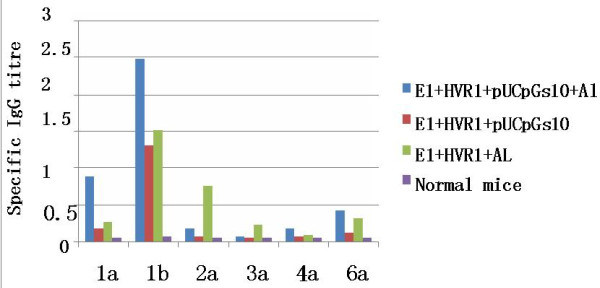
Serum anti-E1a, E1b, E2a, E3a, E4a and E6a IgG responses following immunization with E1+HVR1 with pUCpGs10 and aluminium. Five mice per group were immunized i.m. twice with a 4 week interval. The mice were bled 2 weeks after the third immunization to collect sera for the ELISA. The data are presented as mean serum IgG titres ± SD.